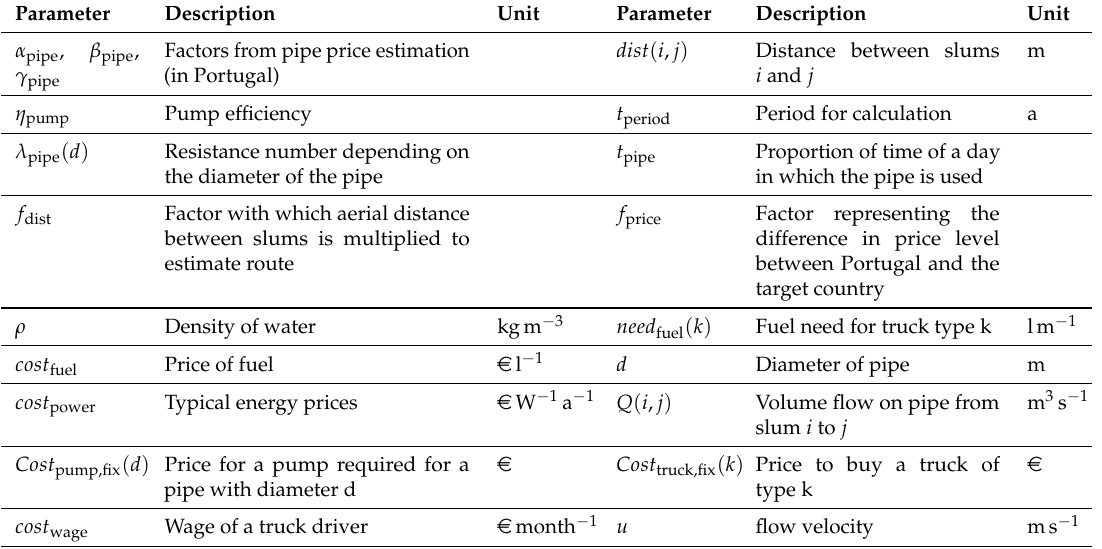
Table 1. Input parameters for the cost